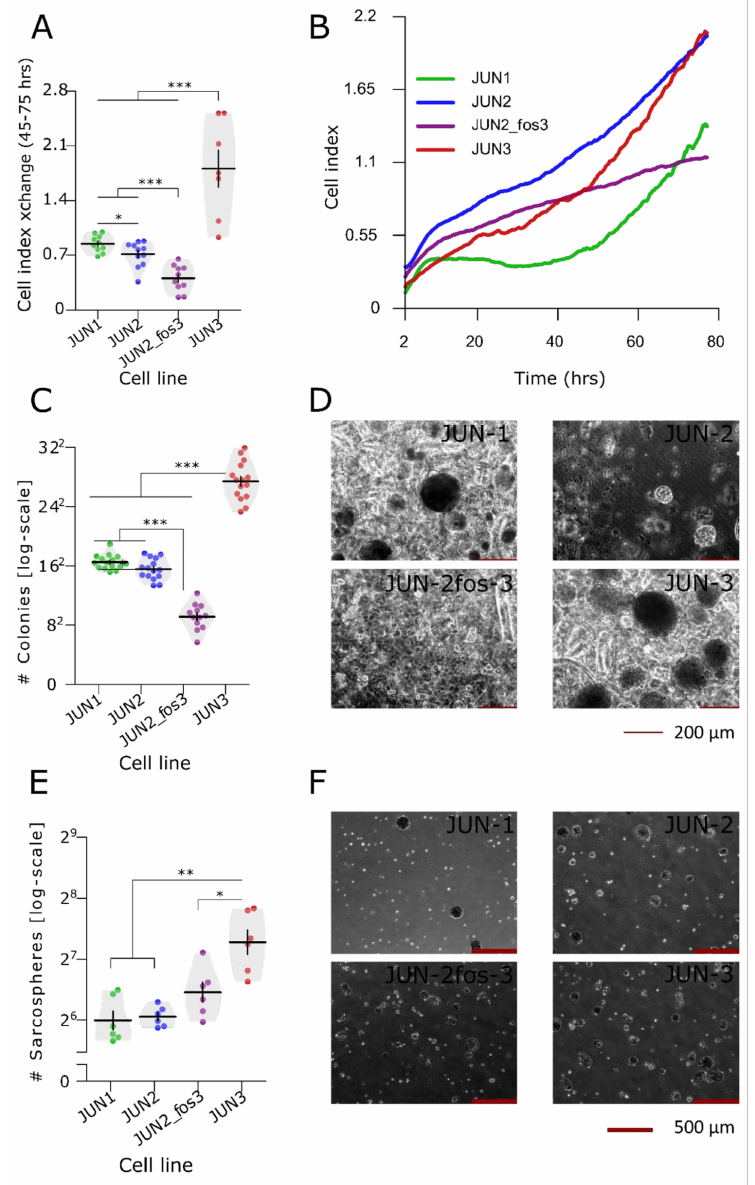
Figure 4. Proliferation and stemness-related characteristics of JUN-sarcoma cell line. ( A ) Proliferation of JUN-sarcoma cell lines. The doubling time and slope analysis (Table 1) were performed on linear growth phase, set arbitrarily as growth curve interval between 45 and 75 h (permutational ANOVA: F 3,34 = 33, p < 0.001). The JUN-3 cell line showed the fastest growth. The proliferative activity of the newly established derivative JUN-2fos-3 was inferior to all the other sarcoma cell lines of the series, even below the proliferative activity of its parental cell line JUN-2. ( B ) Growth curve of the JUN-sarcoma cell lines. ( C ) Clonogenicity in semisolid media differ among JUN-sarcoma cell lines (permutational ANOVA: F 3,53 = 252, p < 0.001). JUN-3 was the most active cell line, whereas the JUN-2fos-3 showed the weakest clonogenicity. Representative pictures of colonies formed in 15% methylcellulose are shown in ( D ). The pictures were taken by the Olympus IX 70 inverted microscope equipped with the Hamamatsu Orca-ER camera at 100 × magnification. ( E ) Sarcosphere formation capacity differed among JUN-sarcoma cell lines (permutational ANOVA: F 3,20 = 14.8, p <